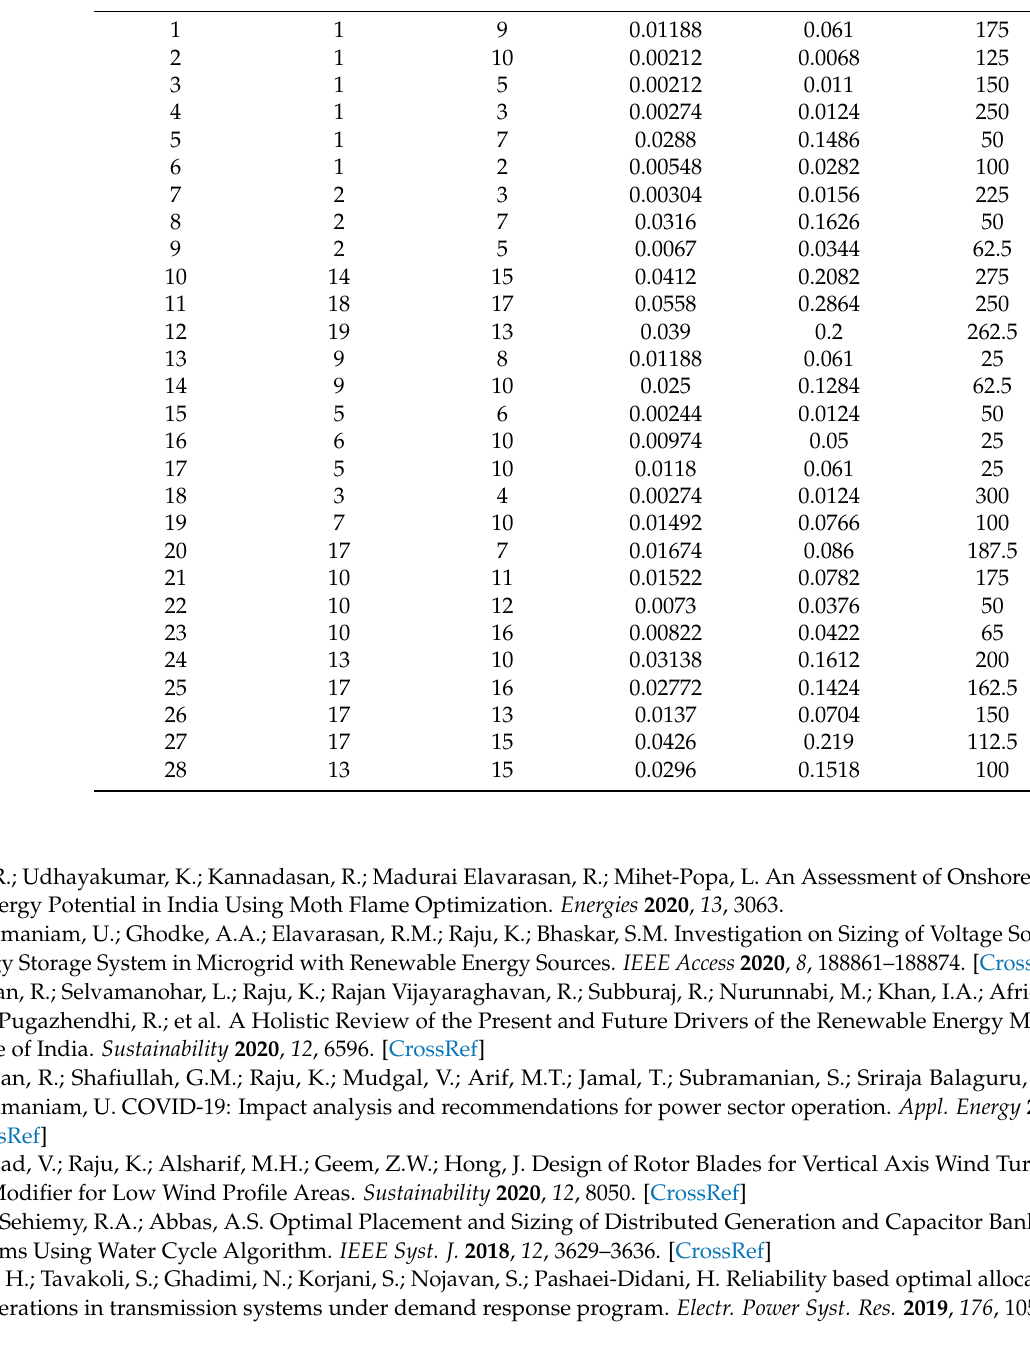
Table A2. Transmission line data of the IUPS. Line